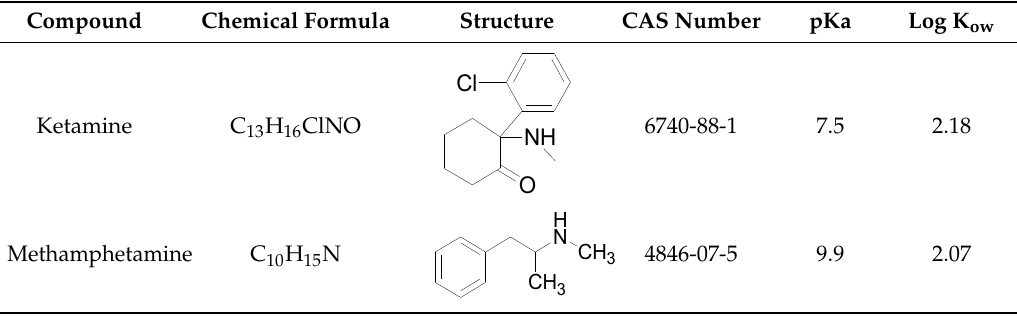
Table 1. Chemical structures and properties of ketamine and methamphetamine.